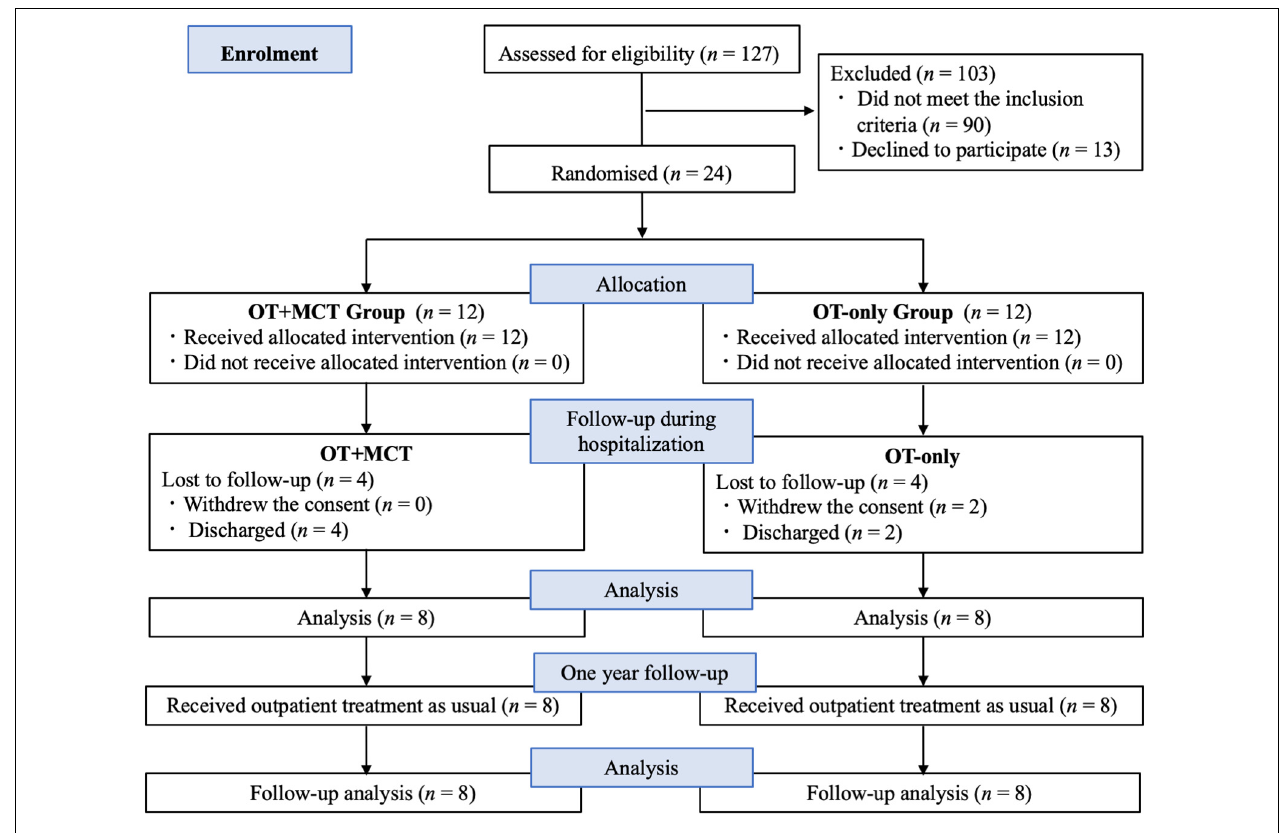
FIGURE 1 | Flow chart of this